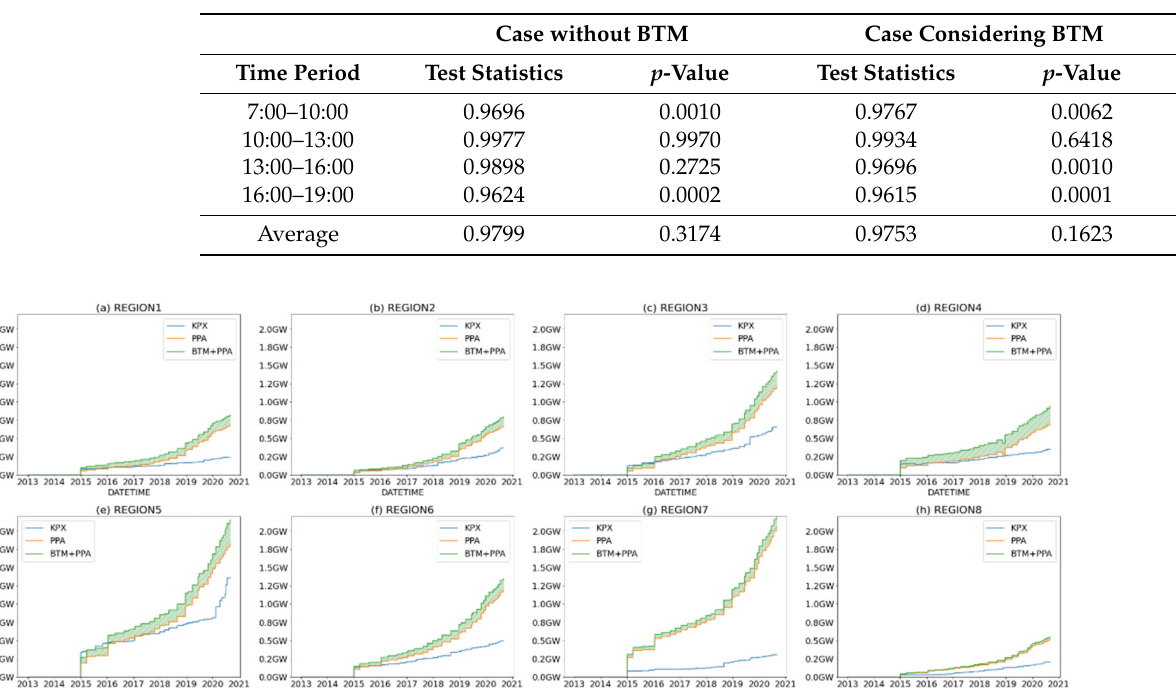
Figure 14. Estimated regional BTM solar capacity using the proposed BTM estimation